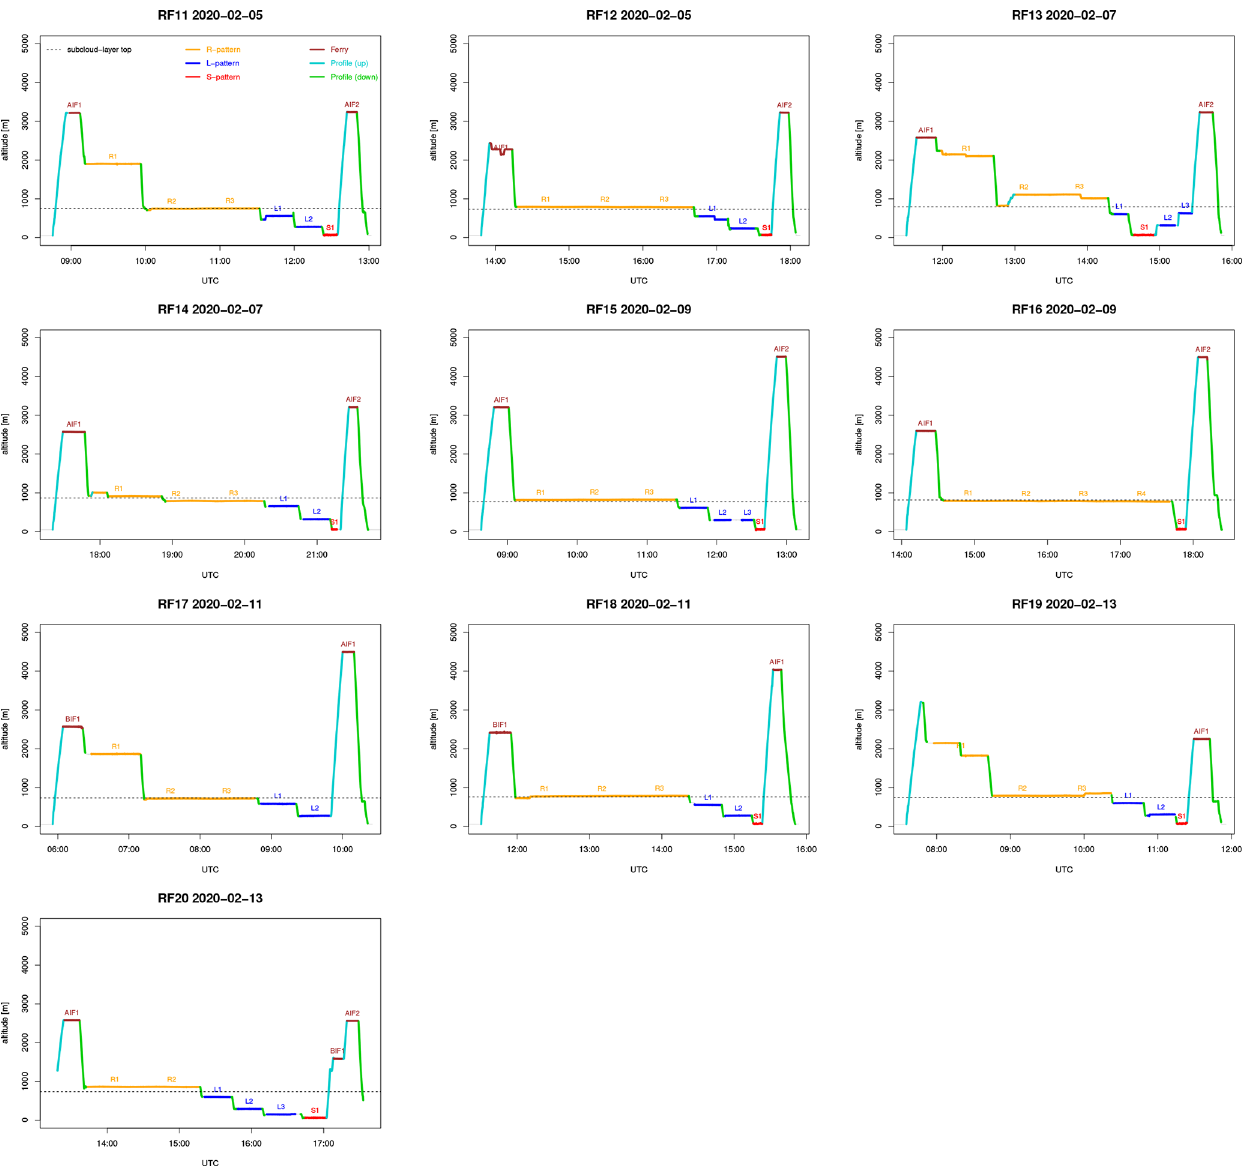
Figure C1. Vertical trajectories of each ATR flight, with the main patterns highlighted in color. R patterns at cloud base and/or cloud top (orange), L patterns in the subcloud layer (blue), S patterns near the sea surface (red), ferry legs (black), and upward and downward profiles (turquoise). Also reported (dashed line) is the subcloud-layer top height diagnosed from dropsondes (Table 3).